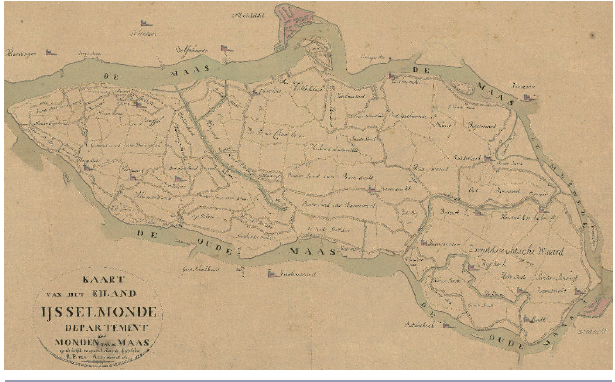
Fig. 1 . Map of IJsselmonde in 1812 (van Alderwerelt